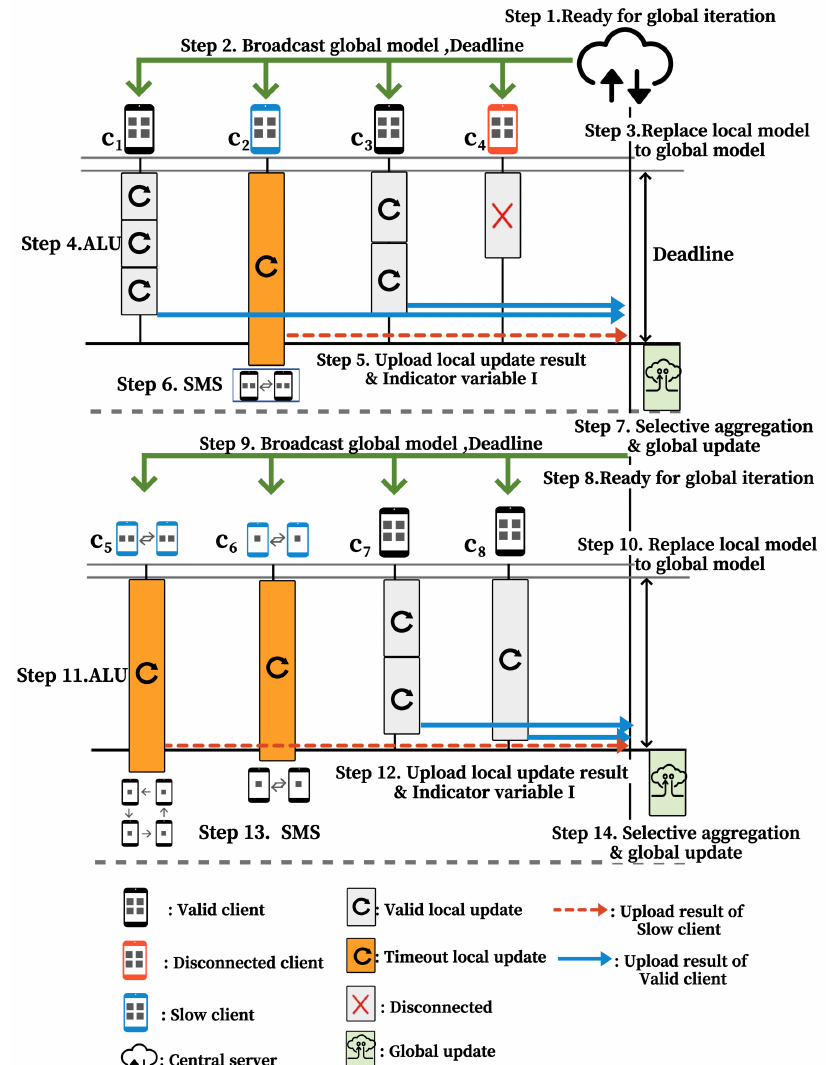
Figure 9. Operational example of